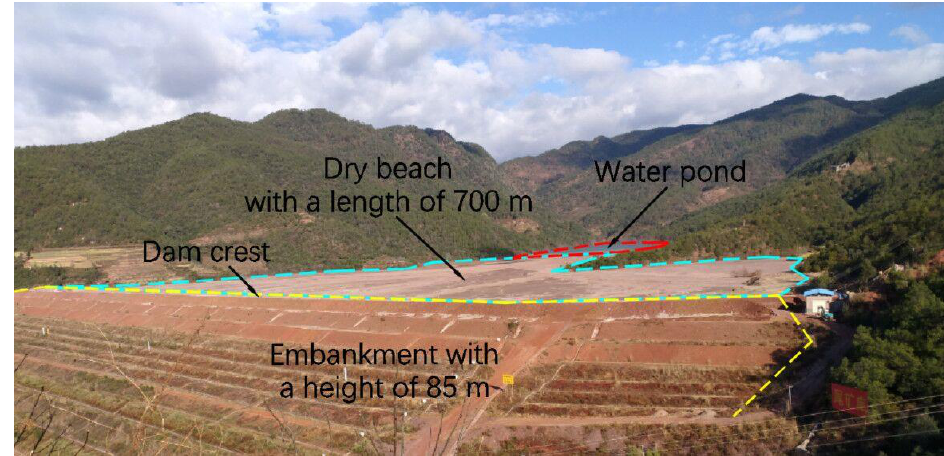
Figure 1. Tailings pond in southwest China.